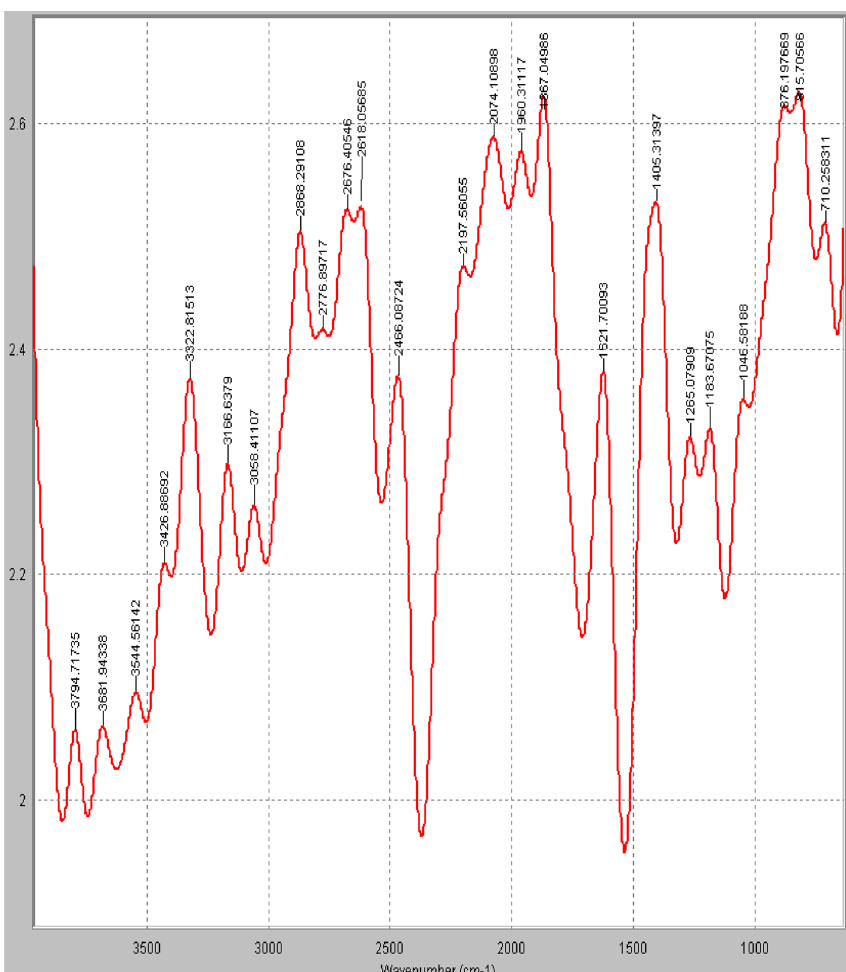
Fig. 2 FTIR spectrum analysis of MSA adsorbent before adsorption of